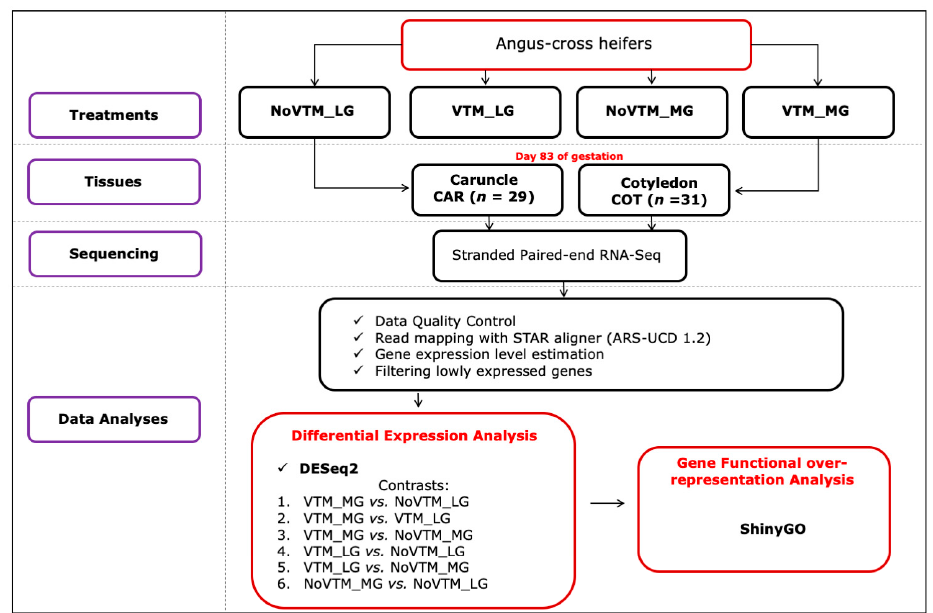
Figure 1. Experimental design and bioinformatics pipeline of the RNA-Seq-based differential ex- pression analysis of bovine placental tissues—caruncle (CAR) and cotyledon (COT). The treatments were arranged as follows: NoVTM_LG—no vitamin and mineral supplementation and low gain; VTM_LG—vitamin and mineral supplementation and low gain; NoVTM_MG—no vitamin and mineral supplementation and moderate gain; and VTM_MG—vitamin and mineral supplementation and moderate